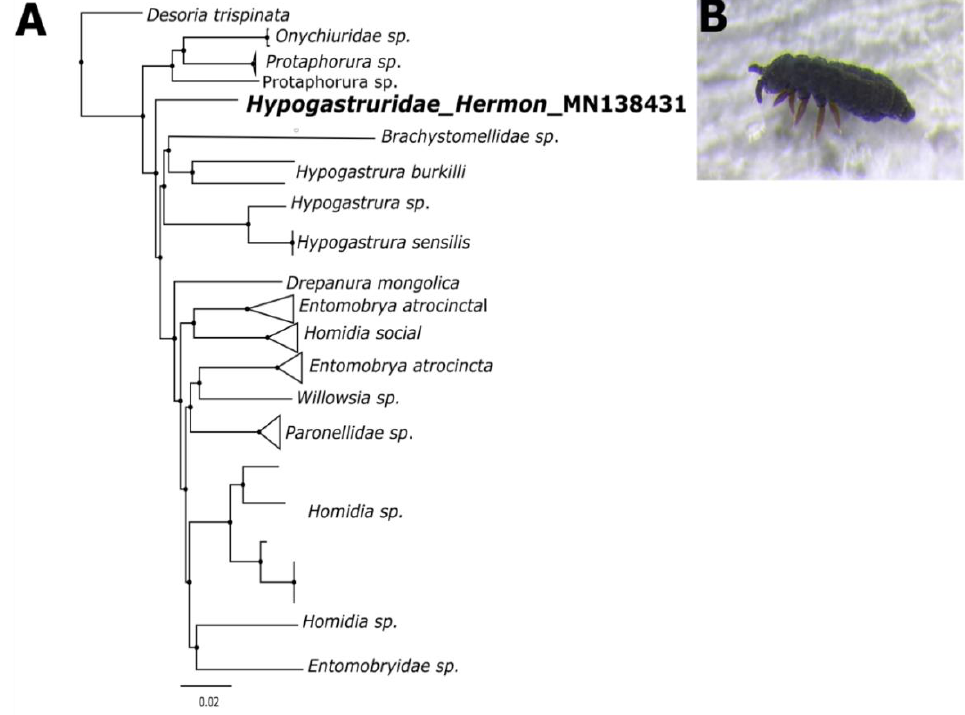
Figure 3. ( A ) Phylogenetic analysis using the neighbor-joining method of uncorrected p-distances based on the 596-bp fragment of the COI gene. ( B ) Image of a Collembola on snow prior to collection.